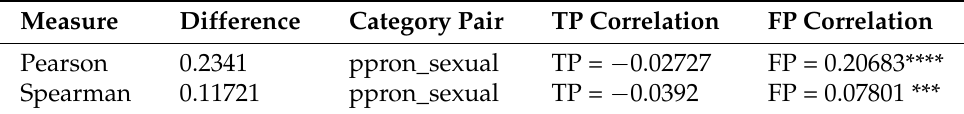
Table 34. Personal pronouns and Sexual words in Medium.